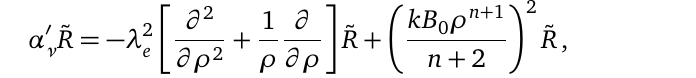
Figure 2: The variation of eigenvalue with eigen-index for B n = 0 (black solid circles), -0.3 (blue dashed asterisks), -0.5 (green dot-dashed tri- angles) and -0.7 (red dotted diamonds). The lines represent the curves fitted with constants of Eq.